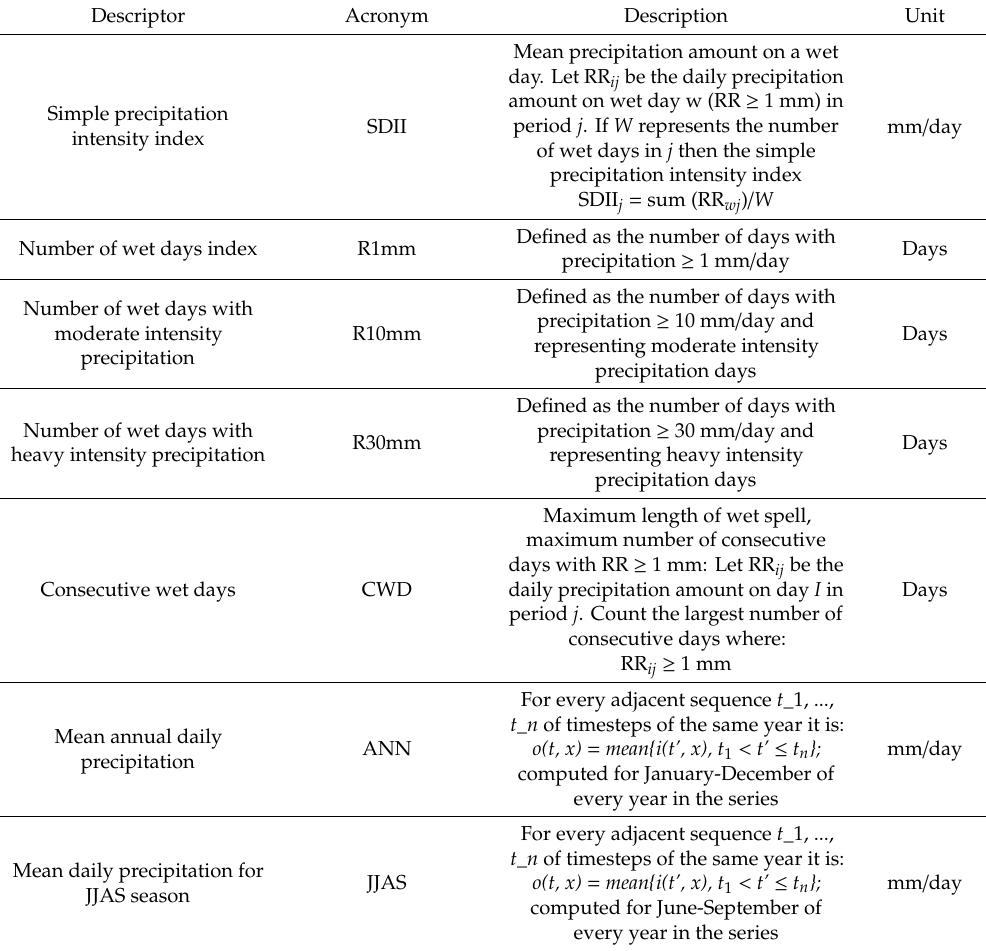
Table 2. Climate indices and precipitation statistics used as descriptors of a precipitation over West